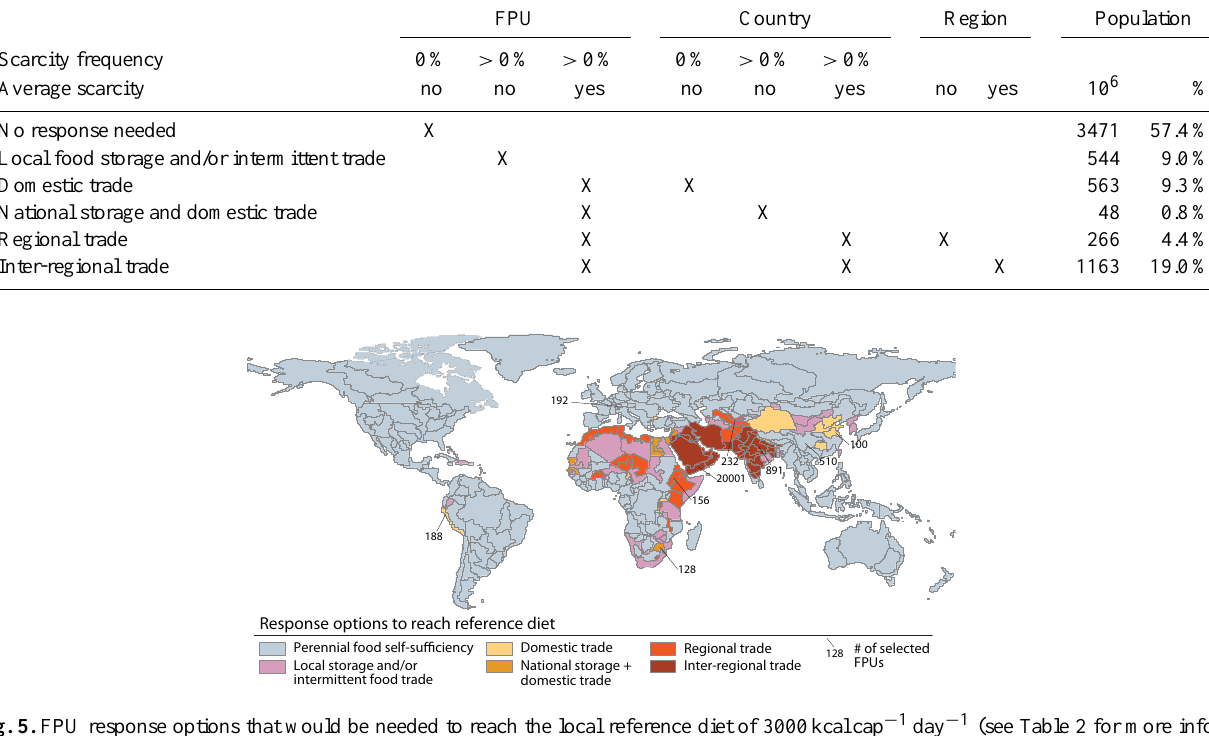
Fig. 5. FPU response options that would be needed to reach the local reference diet of 3000kcalcap − 1 day − 1 (see Table 2 for more infor- mation). Selected FPUs are identified with their code; see Fig. 6 for their location in GBW